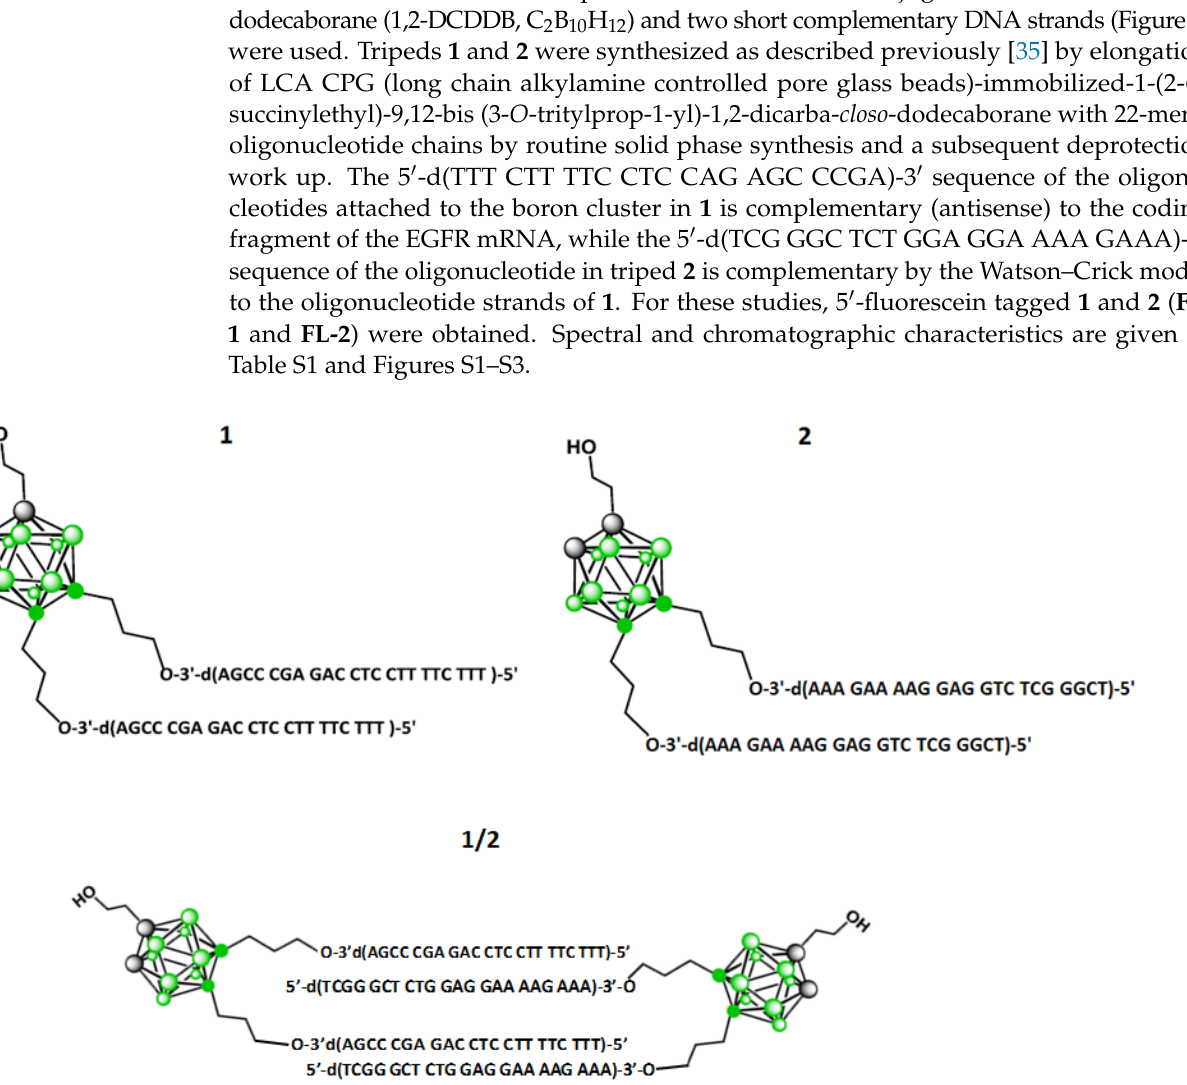
Figure 1. Chemical structures of tripeds 1 and 2 , containing the 1,2-dicarba- closo -dodecaborane scaffold bis -functionalized with either 22 nt 3 ′ → 5 ′ -DNA oligonucleotides complementary to the coding fragment of mRNA of epidermal growth factor receptor (EGFR) or with homologous 22 nt oligonucleotides, respectively, and the chemical structure of dimer 1/2 , composed of one molecule of triped 1 and one molecule of triped 2 , of total 44 bp.